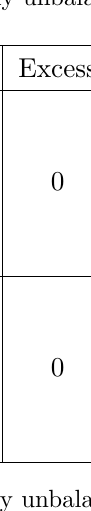
Table 10 . Classi(cid:12)cation of minimally unbalanced quivers with G = F 4 .